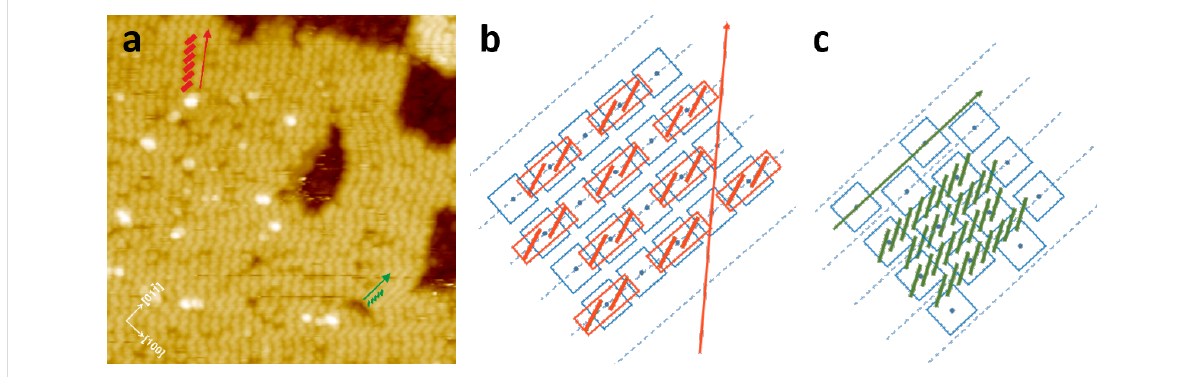
Figure 4: The tentative structural model of the first (b) and the second (c) phases of the molecular chain arrangement within ZnPc islands grown on the ZnPc wetting layer, demonstrating the molecular arrangement of the basic building blocks as identified in the STM image from panel (a). The blue squares with the central point denote flat laying molecules of the wetting layer, red rectangles containing 2 red lines denote the basic building blocks of the phase I structure, green rectangles represent the upright standing molecules of the phase II structure, dotted blue lines denote the direction of the every second protruding oxygen reconstruction rows on the (011)-(2×1) TiO 2 substrate. Note that the flat laying molecules are distributed every second reconstruction row as described above. The STM scanning parameters for the image in (a) are: I = 3 pA; U = 2